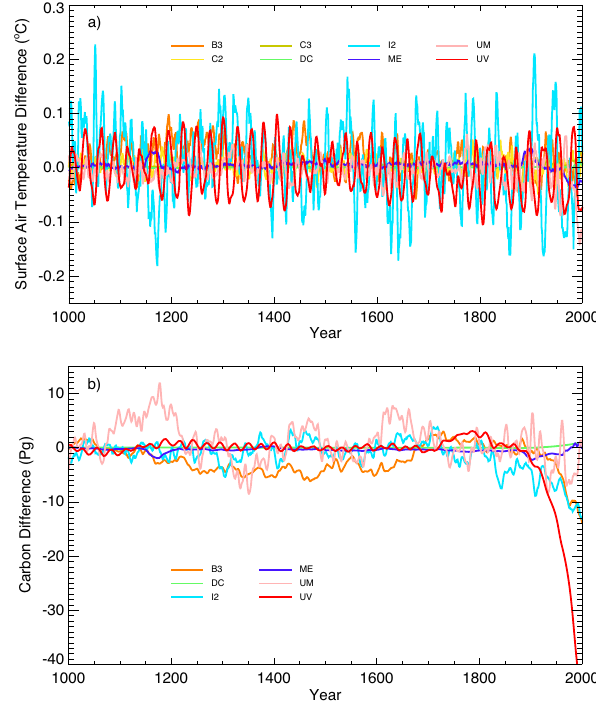
Fig. 9. The linearity of the surface air temperature response (a) and carbon fluxes to the atmosphere (b) over the last millennium. Differ- ences are between anomalies from the all-forcing simulation and the sum of the anomalies from all of the individual forcing component simulations. Model results have been processed with a 5yr moving average, rectangular filter. The differences are shown as anomalies from the average of the century centred at about year 1000. If the in- dividual component responses added linearly to the total response, then the differences should be